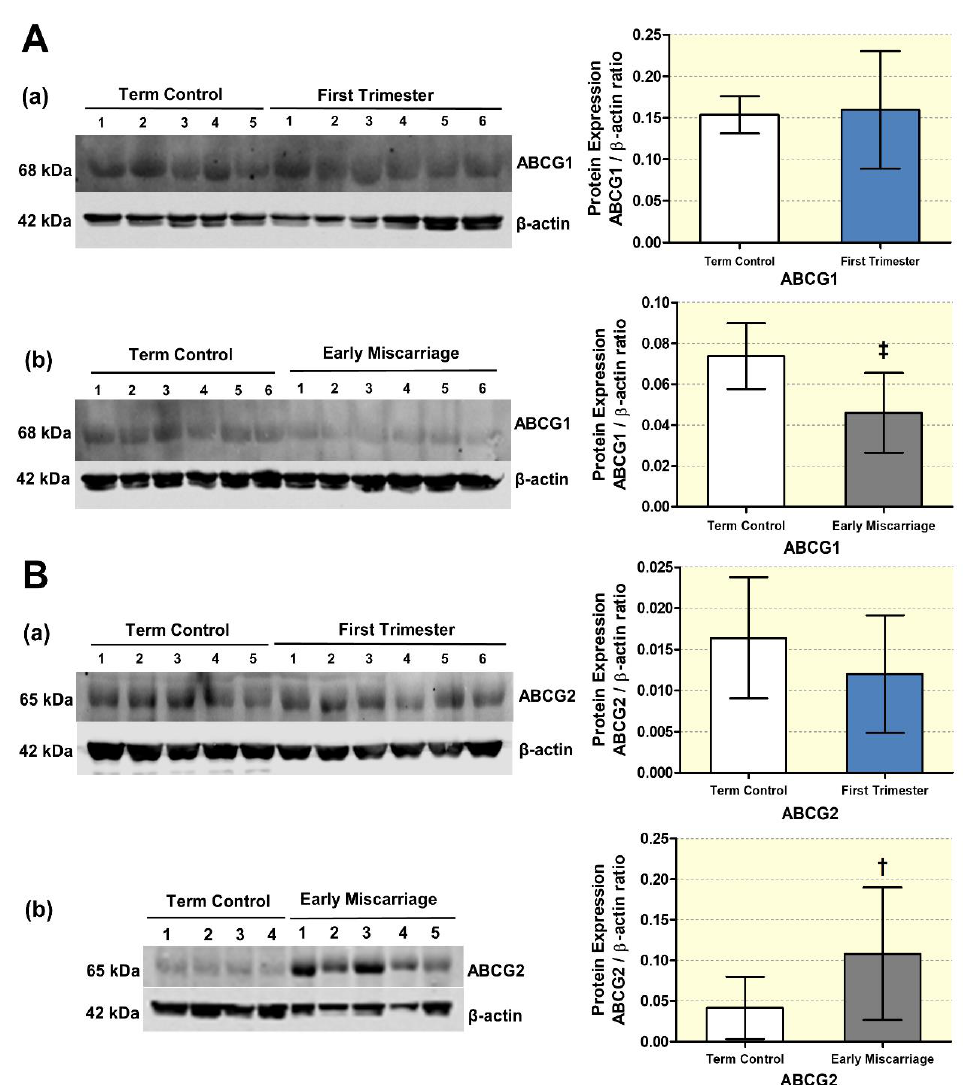
Figure 9. Protein expression changes in ABC transporters in placental tissues. ( A ) ABCG1 and ( B ) ABCG2 expression visualized by immunoblotting in placentae from ( a ) first trimester and term controls ( n = 6 and n = 5, respectively, Swiss cohort) and ( b ) EMC patients and term controls ( n = 20 and n = 19, respectively) was quantified by fluorescence detection analysis and normalized to β -actin as loading control. Results of representative immunoblots for ABCG1 and ABCG2 are shown. Reduced ABCG1 and increased ABCG2 protein levels were observed in EMC patients. Statistical analysis was performed by using two-tailed Mann – Whitney test for comparing first trimester vs. term controls ( a ) and EMC vs. term controls ( b ); ‡: p ≤ 0.001, †: p ≤ 0.01).